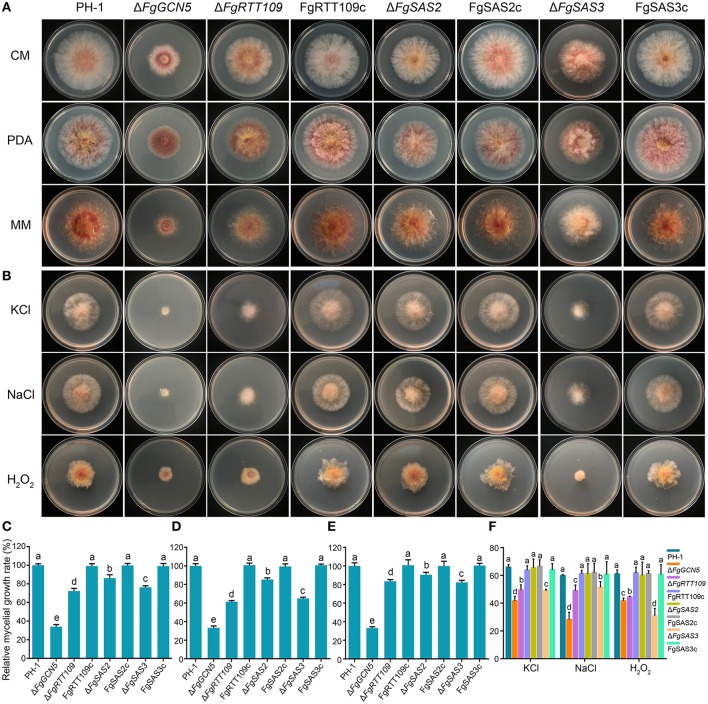
Impacts of four HATs deletion strains on F. graminearum mycelial growth and their sensitivity to osmotic and oxidative stress. (A) The wild-type PH-1, deletion mutants (ΔFgGCN5, ΔFgRTT109, ΔFgSAS2, and ΔFgSAS3) and the complemented strains (FgRTT109c, FgSAS2c, and FgSAS3c) were grown on PDA, CM, and MM at 25°C. (B) Sensitivity of each strain to osmotic stress and oxidative stress. Comparisons were made on MM amended with 1 M NaCl or 1.2 M KCl or 0.069% H2O2. (C,D,E) Relative mycelial growth rate was determined after incubation for 3 days on PDA, CM, and MM. Bars denote standard errors from five repeated experiments. Values on the bars followed by the same letter are not significantly different at P = 0.05. (F) Mycelial growth inhibition was examined after each strain was incubated for 3 days on MM amended with 1 M NaCl or 1.2 M KCl or 0.069% H2O2. Bars denote standard errors from five repeated experiments. Values on the bars followed by the same letter are not significantly different at P = 0.05.